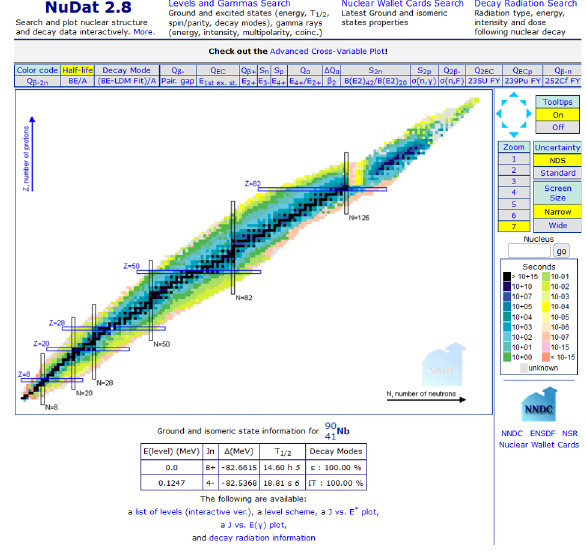
Figure 4. NuDat data dissemination